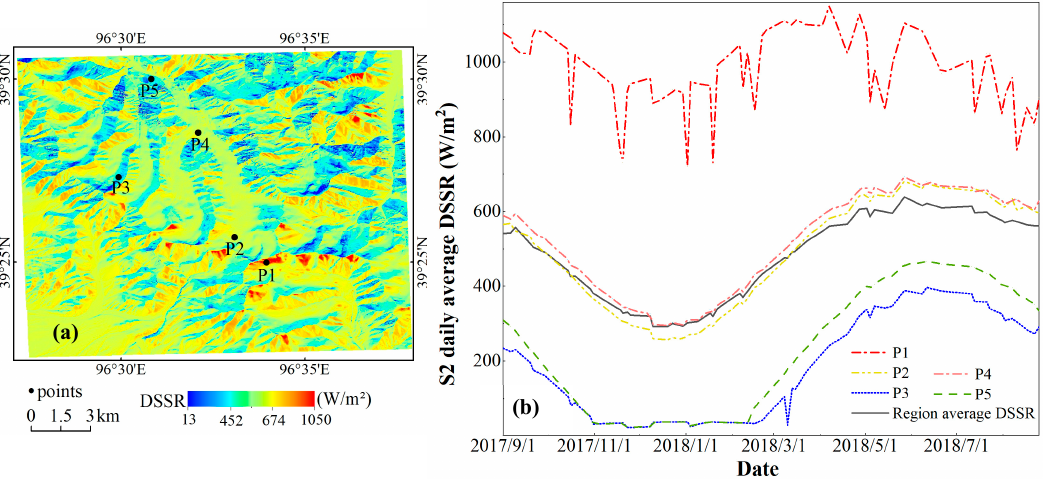
Figure 9. Variation trend for the daily average DSSR from September 2017 to August 2018: ( a ) loca- tions of the five points on the DSSR map and ( b ) temporal variation curves of solar radiation.